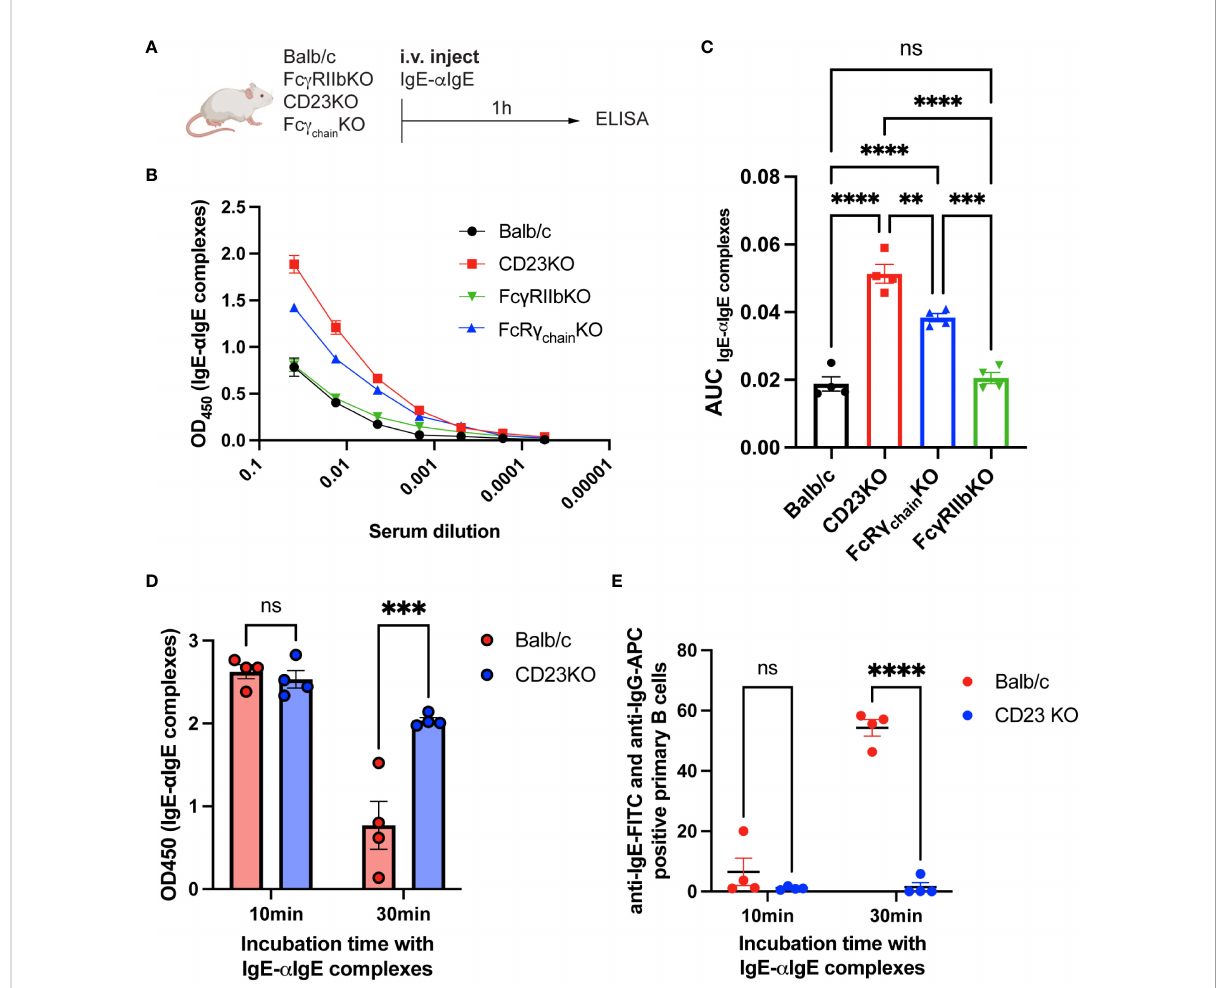
FIGURE 5 IgE-IgG complexes are mainly eliminated by CD23. Experimental overview for the clearance of IgE-anti-IgE IgG immune complexes (A) . IgE- anti-IgE IgG serum levels 1h after injection are shown as ELISA OD450 results (B) and as the area under the curve of the ELISA plot (C) . ELISA results of supernatant from IgE-anti-IgE IgG incubated with primary mouse B cells after 10min and 30min (D) . FACS results of anti-IgE and anti- IgG positive primary mouse B cells after 10min and 30min incubation with IgE-anti-IgE IgG immune complexes (E) . Statistical analysis (mean ± SEM) using one-way ANOVA (C) and two-way ANOVA (D , E) . n = 4 per group. The signs for statistical signi fi cance are ns = not signi fi cant, p ≤ 0.01 (**), p ≤ 0.001 (***), and p ≤ 0.0001